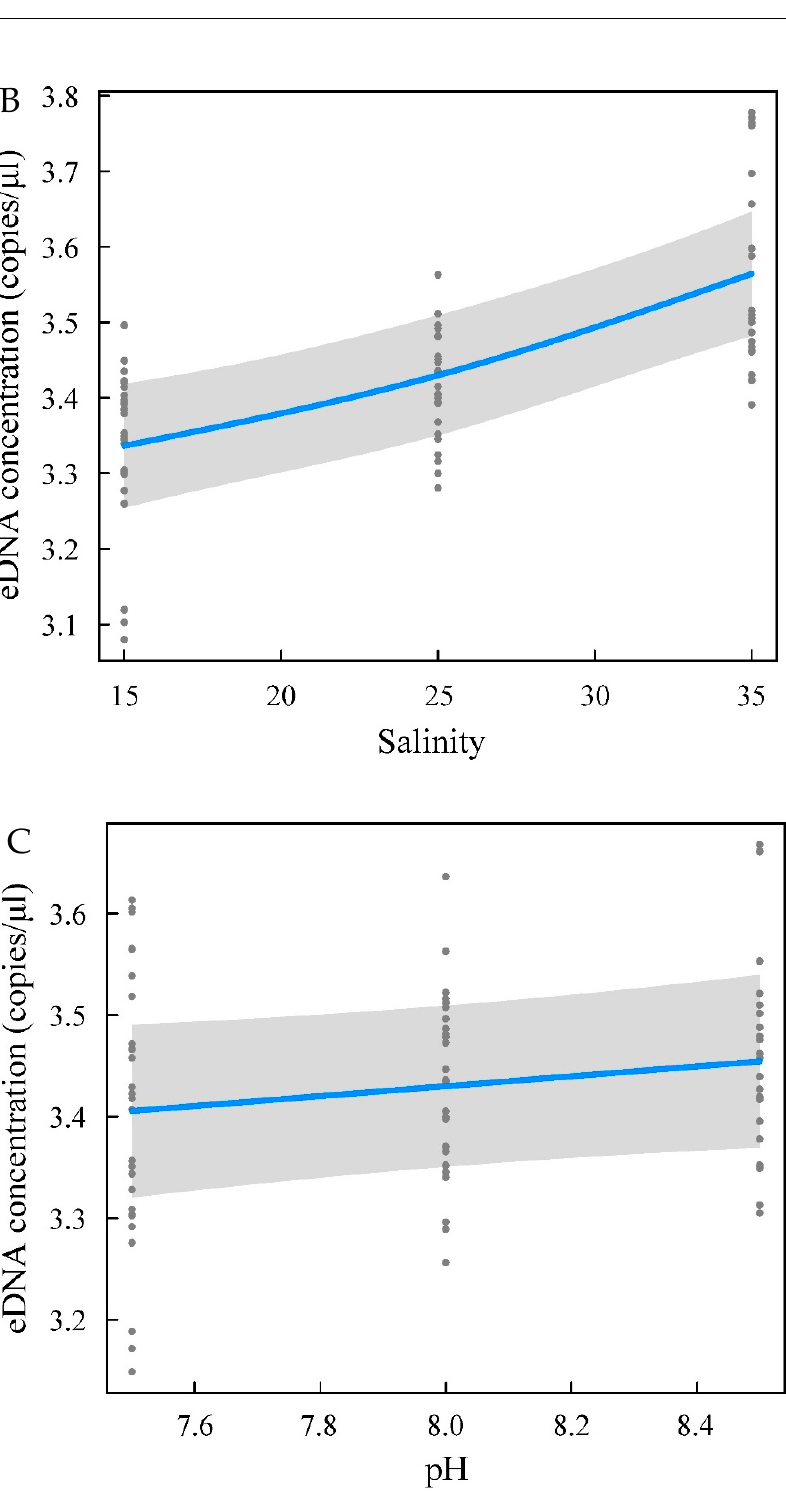
Figure 5. Relationship between different environmental factors and the eDNA concentration of A. latus : ( A ) Temperature, ( B ) Salinity, and ( C ) pH. Each data point represents the mean value of three replicates. The grey shaded areas around the regression lines show the 95% confidence interval.